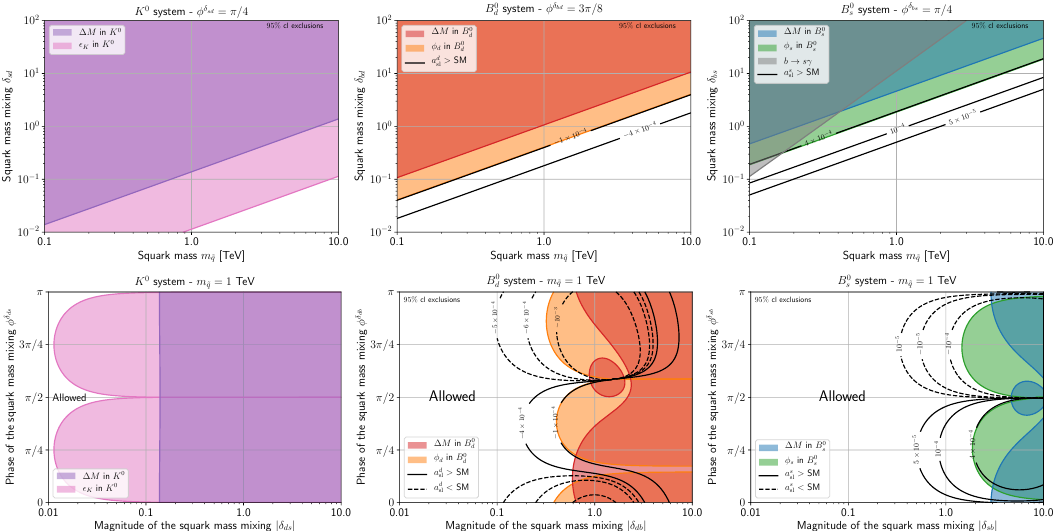
Figure 3. Constraints on the soft squark masses coming from the bino contribution to mixing in neutral meson K , B 0 and B 0 systems. The shaded areas are excluded by the CP conserving and s d violating observables indicated in the labels, which are explained in section 3. For simplicity, we assume an approximately universal value m ~ q for the diagonal elements of the mass matrix. The dependence on the bino mass drops out as long as m ~ m ~ q . The upper panels show constraints B (cid:28) assuming maximal CP violation, while the lower ones show the dependence on the phases of the squark mass matrix elements. The contour lines in the B 0 and B 0 cases represent values of the s d semileptonic asymmetry in each system. As expected, the kaon sector measurements gives the strongest limits, showcasing the need for some (cid:13)avor structure to produce sizeable contributions to the semileptonic